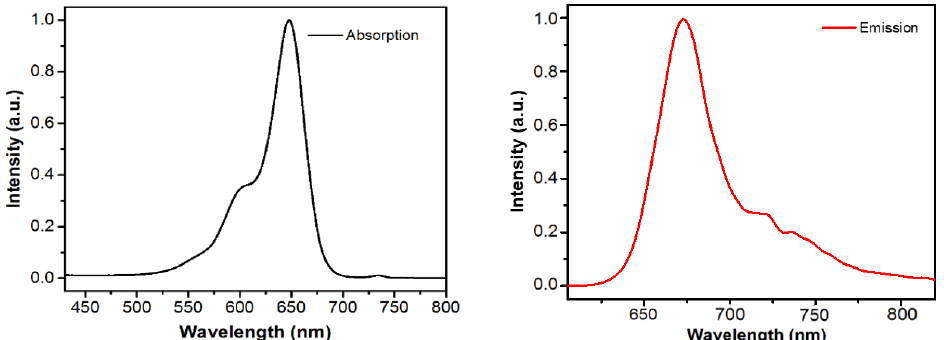
Figure 2. ( A ) The Absorption spectra of CCY-5. Optical absorption spectra were collected with a Perkin-Elmer Lambda365 UV / Vis spectrometer in absorption mode. ( B ) The Emission spectra of CCY-5. PL emission spectra were recorded on the FLS980 spectrometer (Edinburgh) equipped with both continuous Xenon (450 W).